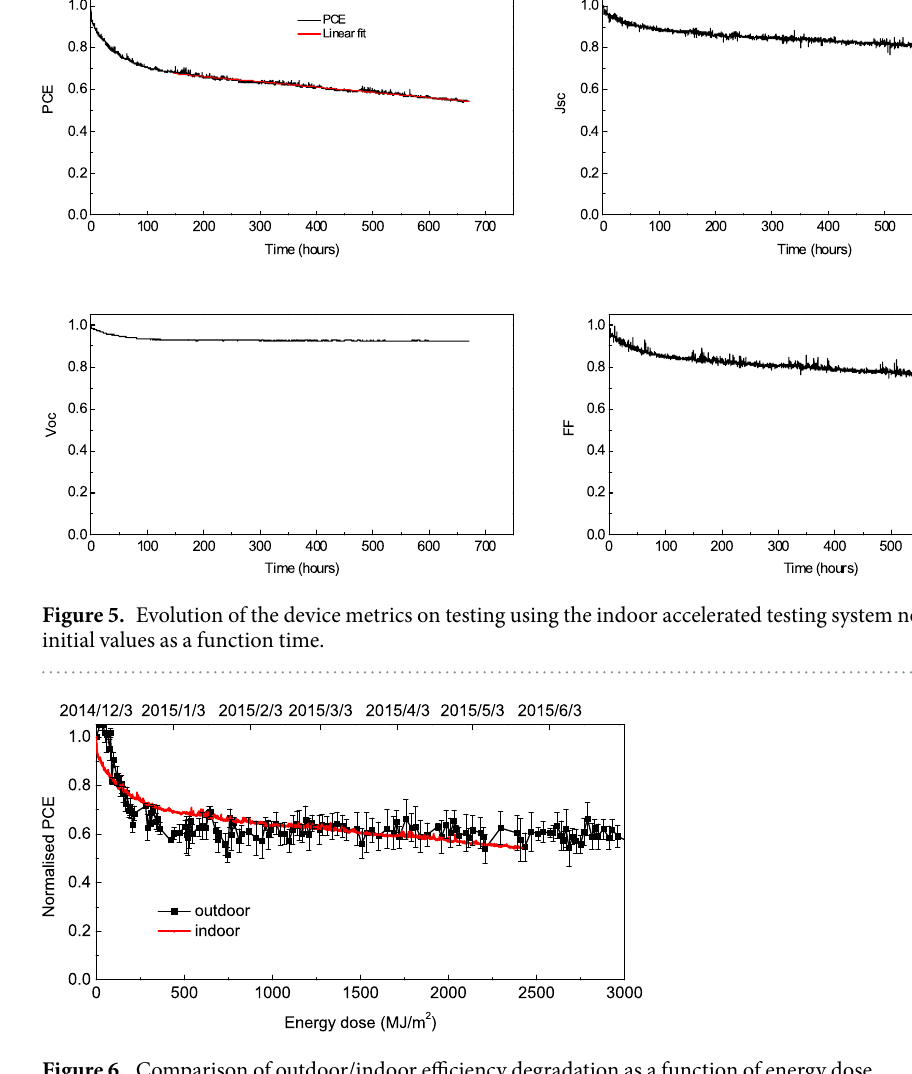
Figure 6. Comparison of outdoor/indoor efficiency degradation as a function of energy dose.